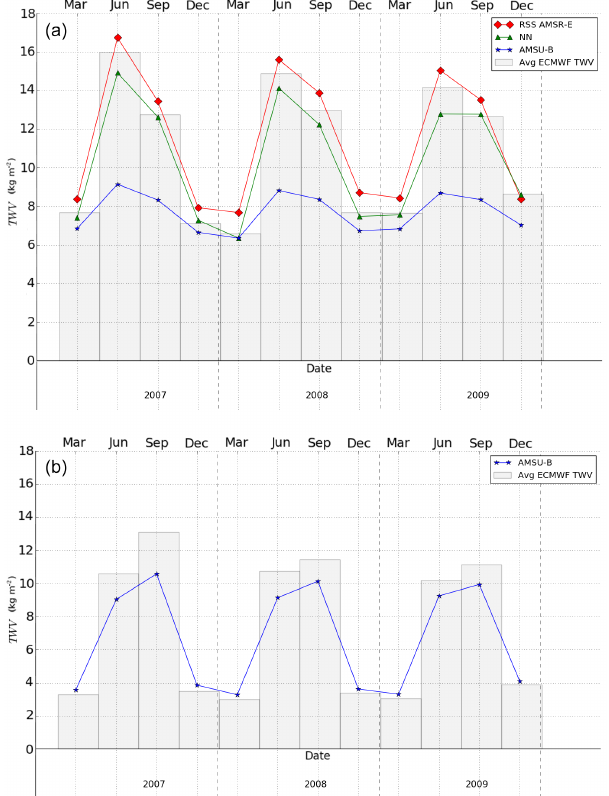
Figure 12. Average TWV values for the three tested retrievals plot- ted over ECMWF average TWV values for open-ocean areas (a) and new AMSU-B alone plotted over ECMWF average TWV values including all open-water, land and sea-ice-covered regions of the Arctic where valid values can be retrieved (b) . The curves represent the monthly averaged TWV values for each algorithm. The vertical columns in the background represent the monthly mean TWV value from ECMWF